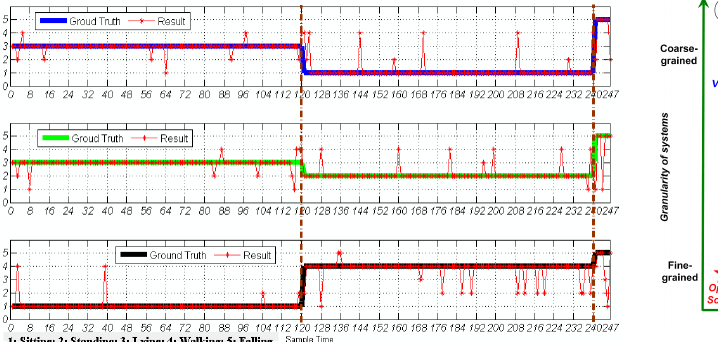
Figure 18: Design Space: comparing to related